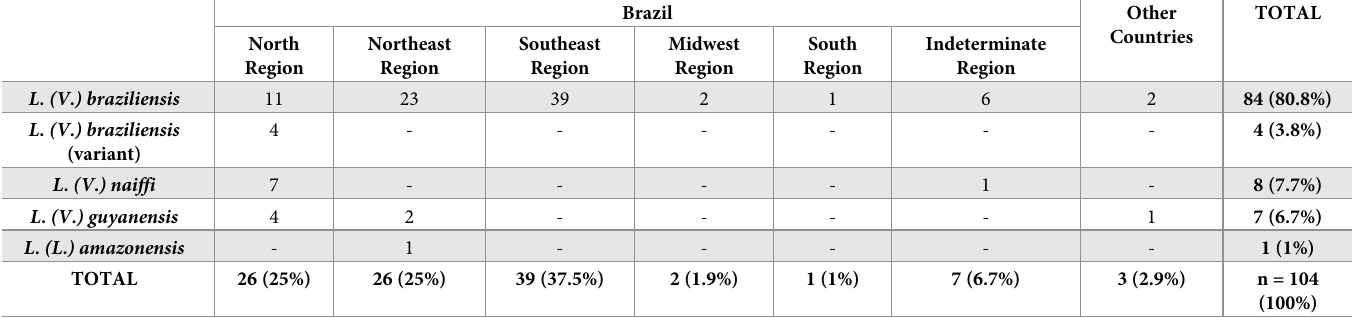
Table 5. Species of Leishmania identified according to likely location of infection in Brazilian regions or other countries.